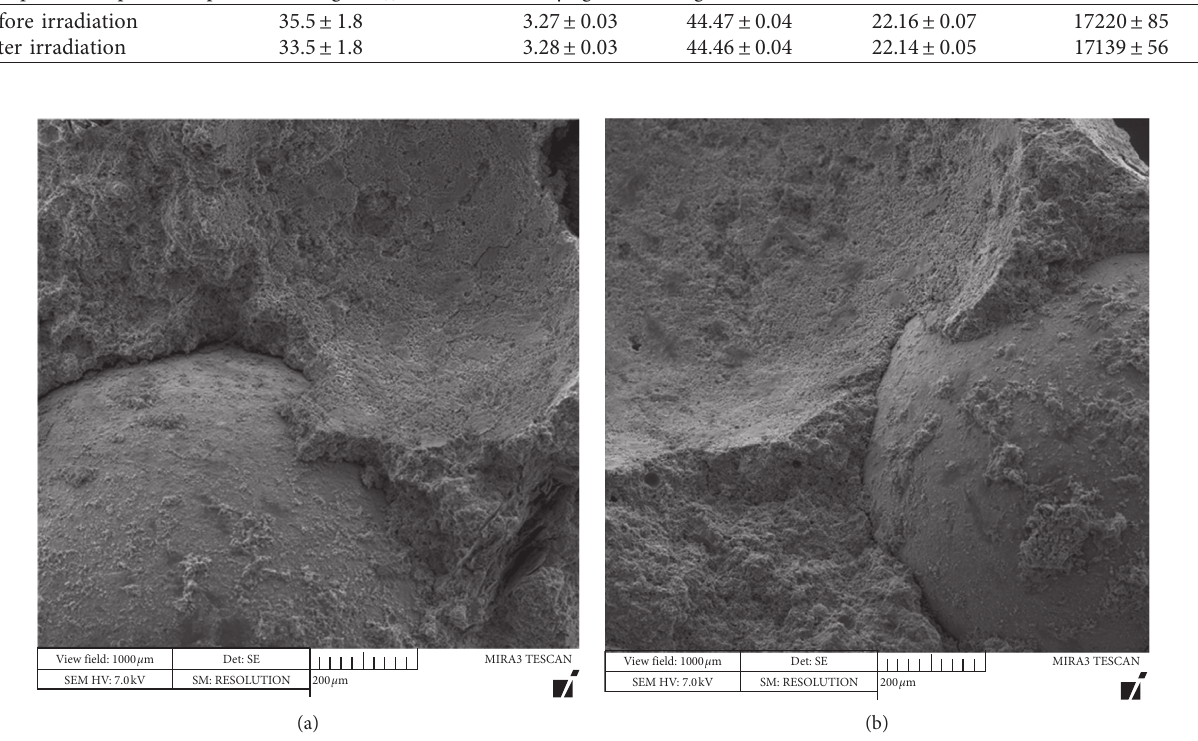
Figure 6: Surface microstructure (SEM) of a fracture of a cement composite based on unmodified (a) and modified (b) shot of titanium hydride subjected to c -irradiation, at a dose D �